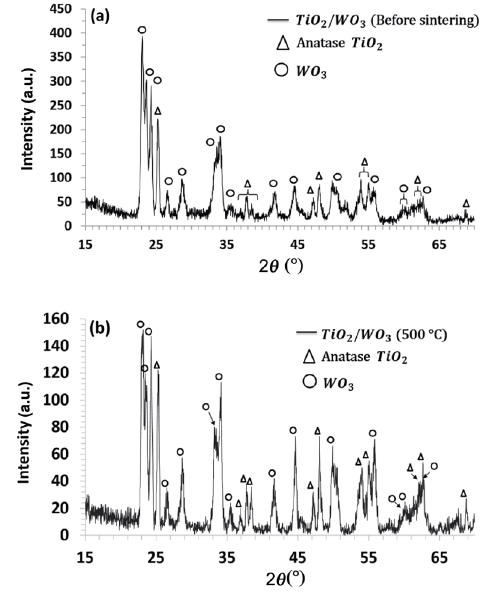
Fig. 3 XRD spectra of (a) non-sintered TiO 2 /WO 3 and (b) sintered nanostructures at 500 ℃ .